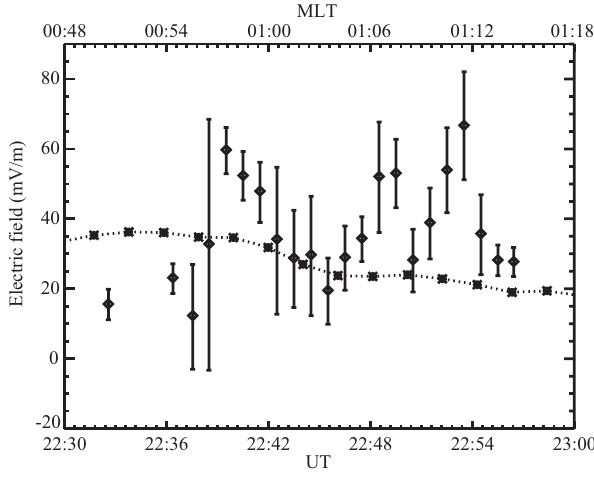
Fig. 5. Reconnection electric field at the OCB determined using EISCAT observations (diamonds) and SI12 and SuperDARN data (stars) on 17 February 2002.